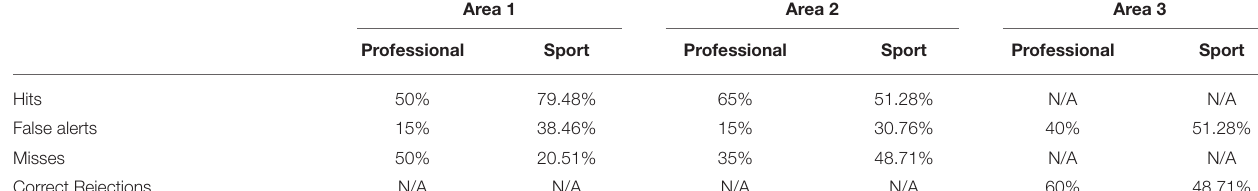
TABLE 3 | Overview of Professional and Sport dog-handler team performance in each area. Each cell shows the percentage of handlers that made the respective response (out of 20 professionals and 39 sport handlers).